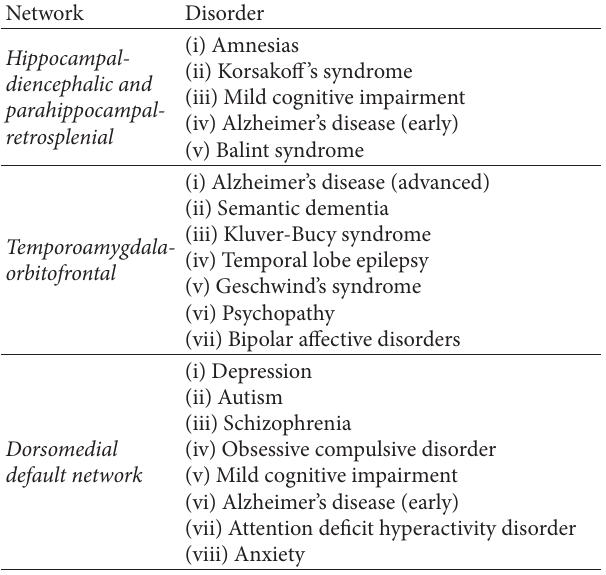
Table 4: Limbic networks and neuropsychiatric disorders